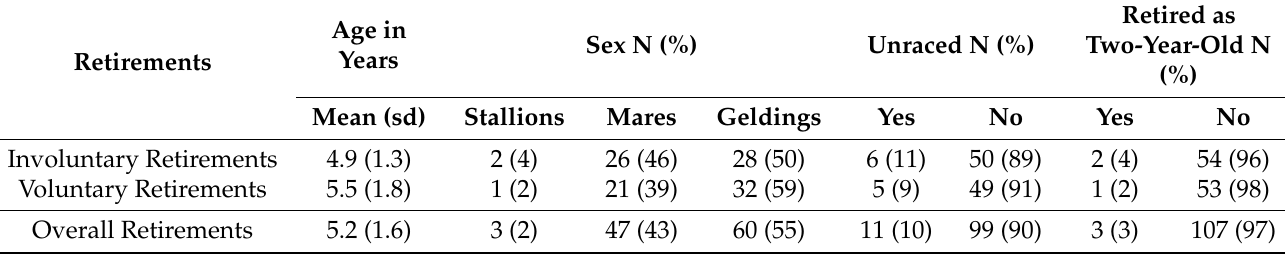
Table 3. The population characteristics of 110 retired Thoroughbred racehorses in South East Queensland, stratified by whether retirement was voluntary or involuntary.